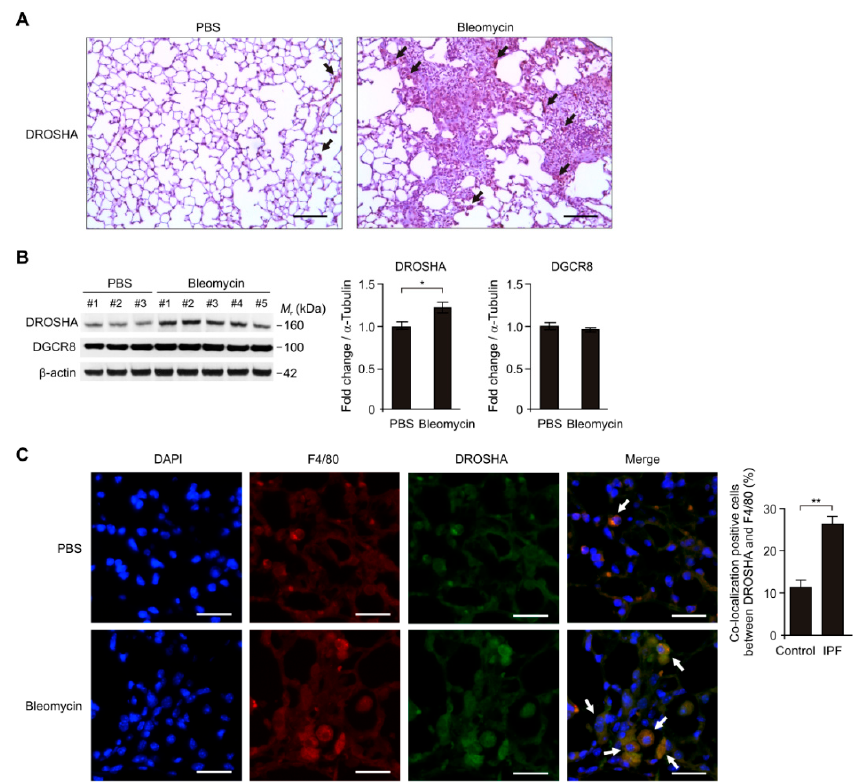
Figure 3. The DROSHA protein levels were elevated in alveolar macrophages during bleomycin-induced pulmonary fibrosis. ( A ) Representative immunohistochemistry image of DROSHA in lung tissues from wild-type (WT) mice were exposed to PBS or bleomycin via oropharyngeal aspiration. Positive area and cells are indicated by the black arrow. Scale bars, 200 μ m. Results are representative